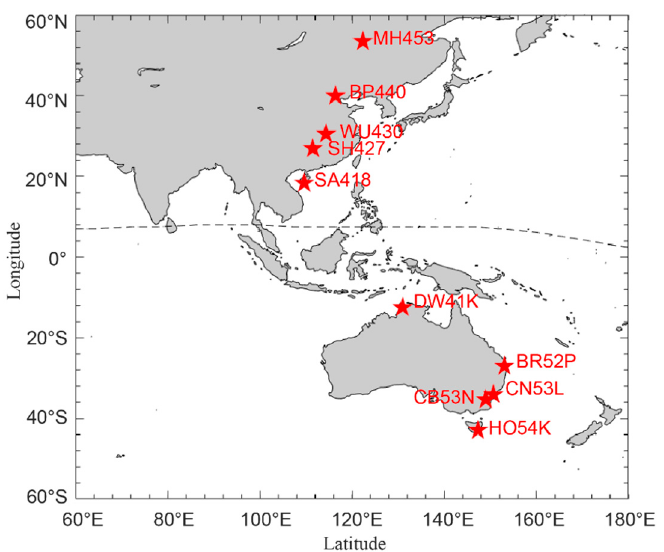
Figure 4. Spatial distribution map of the ionosonde stations. The URSI code in red font and the red stars indicate the name and the location of the selected ionosonde stations, respectively.